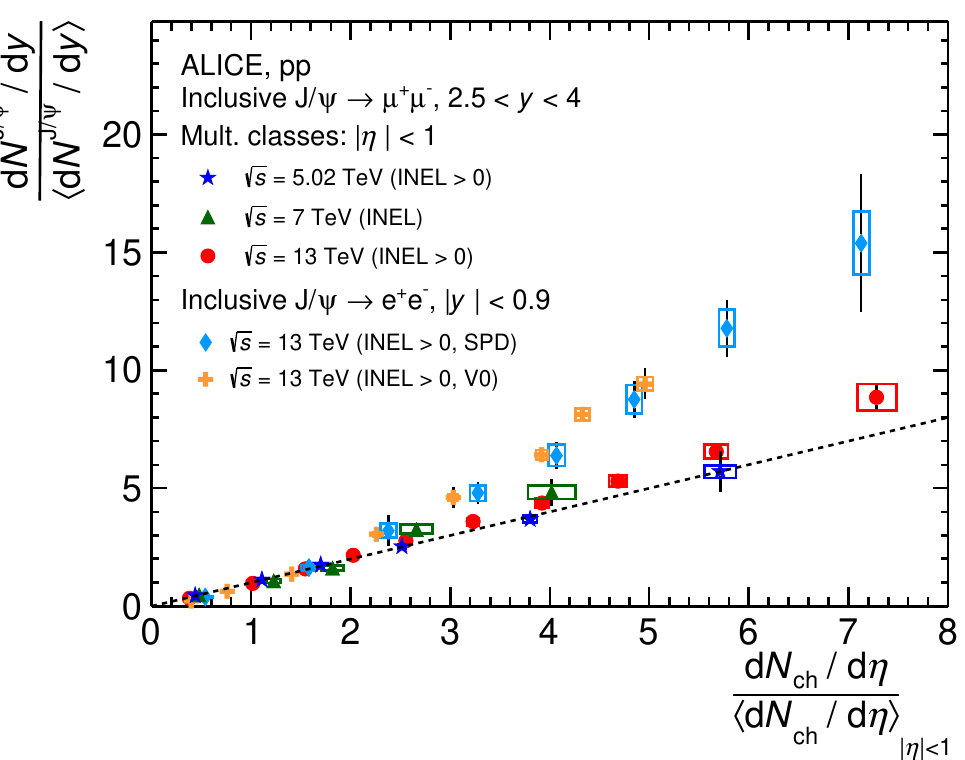
√ s = 5.02, 7 and 13 TeV compared √ s = 13 TeV, the latter corresponding to the event